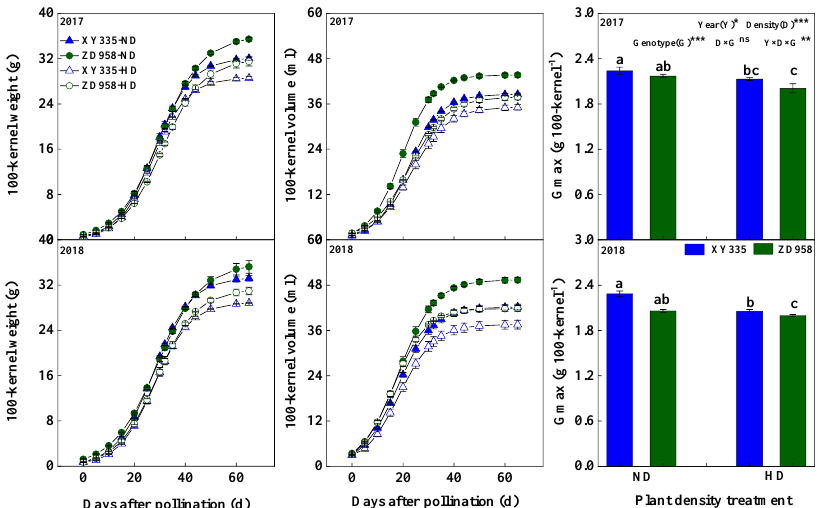
Figure 2. Dynamics of 100-kernel weight, 100-kernel volume and Gmax of two maize hybrids after pollination under ND and HD conditions in 2017 and 2018. Gmax, maximum grain-filling rate; ND and HD indicate 60,000 and 90,000 plants ha − 1 density, respectively. Values shown are the mean ± SE ( n = 3). Letters on column chart indicate statistically significant differences between treatments at p < 0.05. ns, not significant; *, ** and *** indicate significant difference at p < 0.05, p < 0.01, and p < 0.001, respectively.